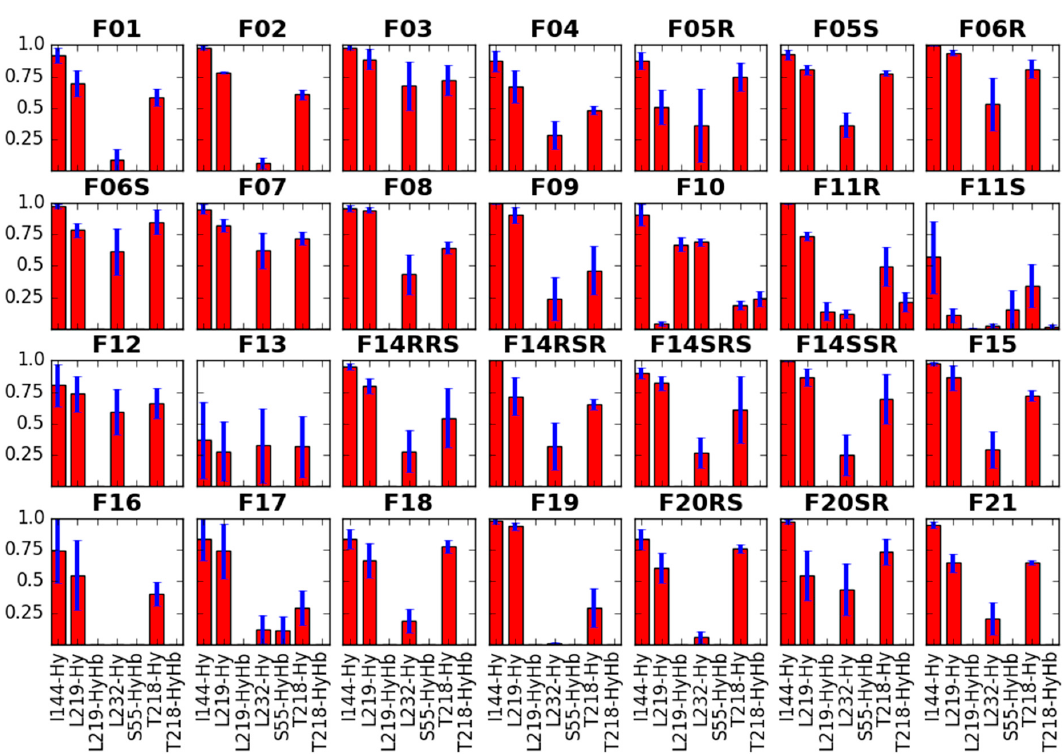
Figure 5. Interactions of the propanamide chain with the receptor residues. Red bars represent the mean frequency of contacts with a particular residue, and blue bars show standard error of the mean. Data are collected from last 10 ns of production in 3 replicas. In x -axis label given is the residue’s name and number as well as type of the contact (Hb—hydrogen bond, Hy—hydrophobic, A—aromatic).